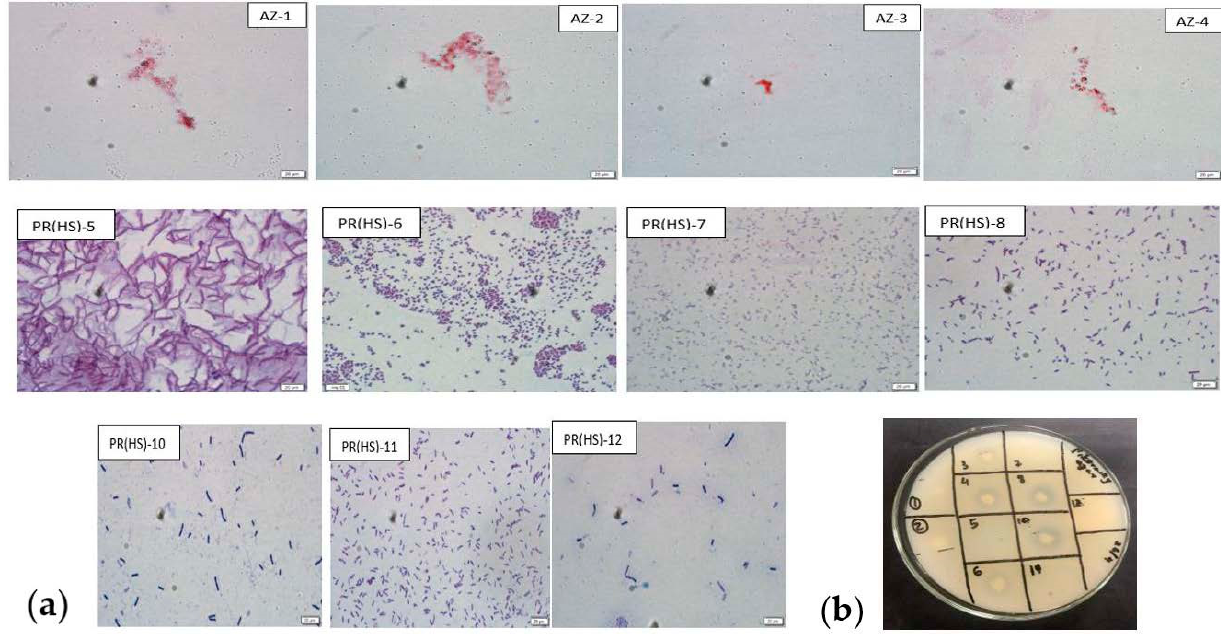
Figure 2. ( a ) Microscopic images of Gram-stained bacterial isolates (1st row (left to right)—Ashby isolates, AZ-1, 2, 3, 4 with negative Gram character. Second and third row—PGPR isolates, PR(HS)-5, 6, 7, 7, 10, 11 and 12 with positive Gram character). ( b ) Phosphate solubilization test for isolates PR(HS)-1, 2, 3, 4, 5, 6, 7, 8, 10,11 and 12. Clear halo zones around the isolates PR(HS)-3, 4, 6, 8 and